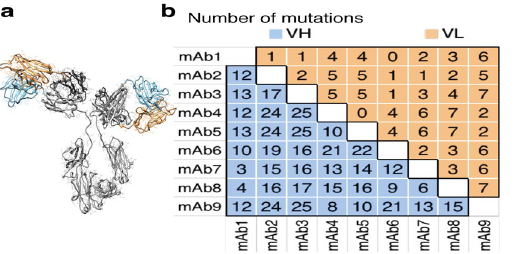
Figure 2. Comparison of the monoclonal antibody variants used in this study. ( a ) Structural model of a monoclonal antibody with the constant domains coloured in grey and the variable domains in orange (VL) and light blue (VH). ( b ) Table summarising the number of mutations distinguishing any two mAb variants employed in this study; the VH domain is shown in the lower-left half and the VL domain in the upper-right